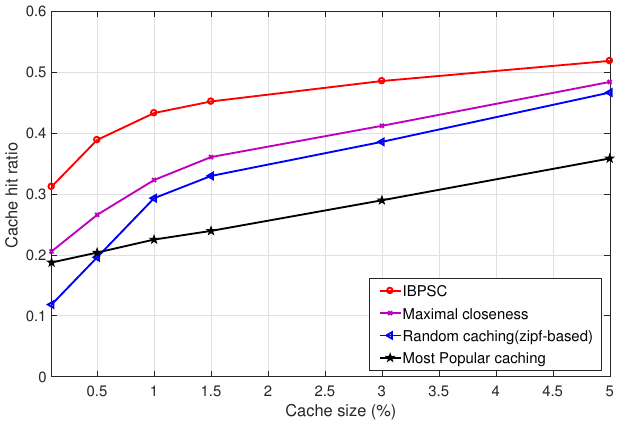
Figure 5. Cache hit ratio vs. cache size.